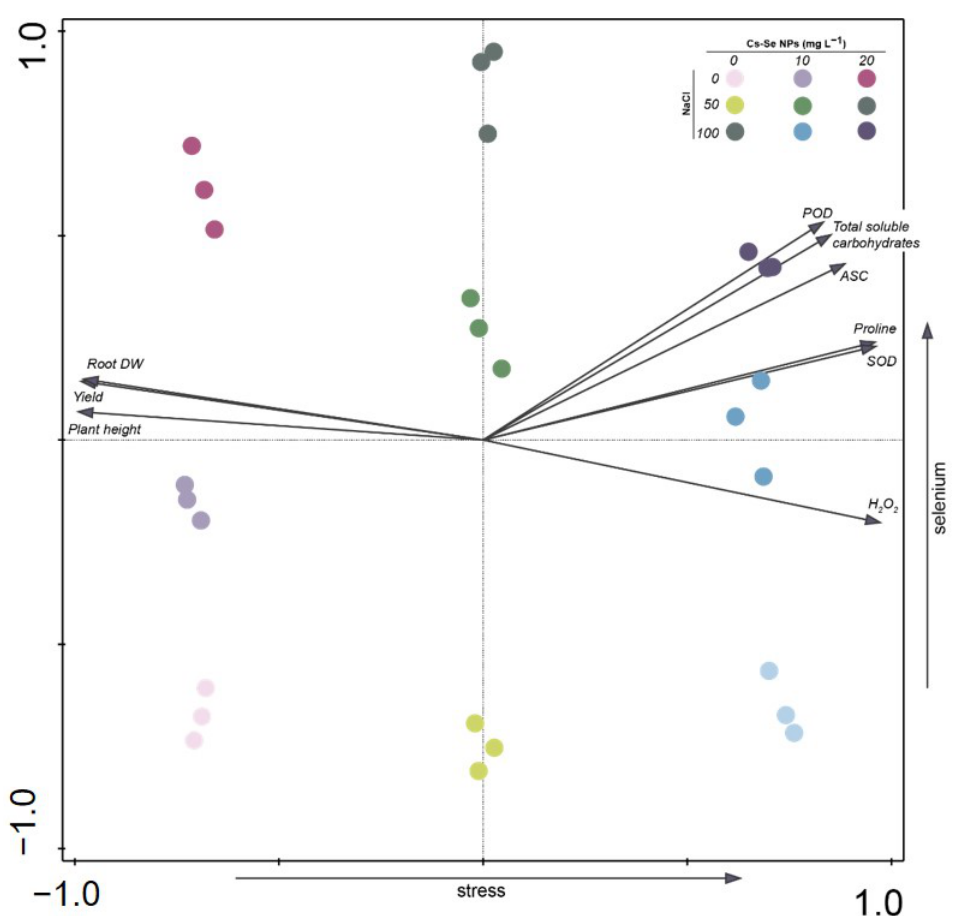
Figure 6. Ordination diagram—PCA (principal component analysis). The bi-plot displays treatments with Cs-Se NPs (0, 10, and 20 mg L − 1 ) and salinity stress (0, 50, and 100 mM NaCl). The first and second axes together explain 90.01% of variance. The selenium amount is shown by the color intensity of the circle. The basic color (purple, green, blue) is determined by the salinity stress (table in graph). The arrows show reaction of bitter melon (physiological parameters) under stress.